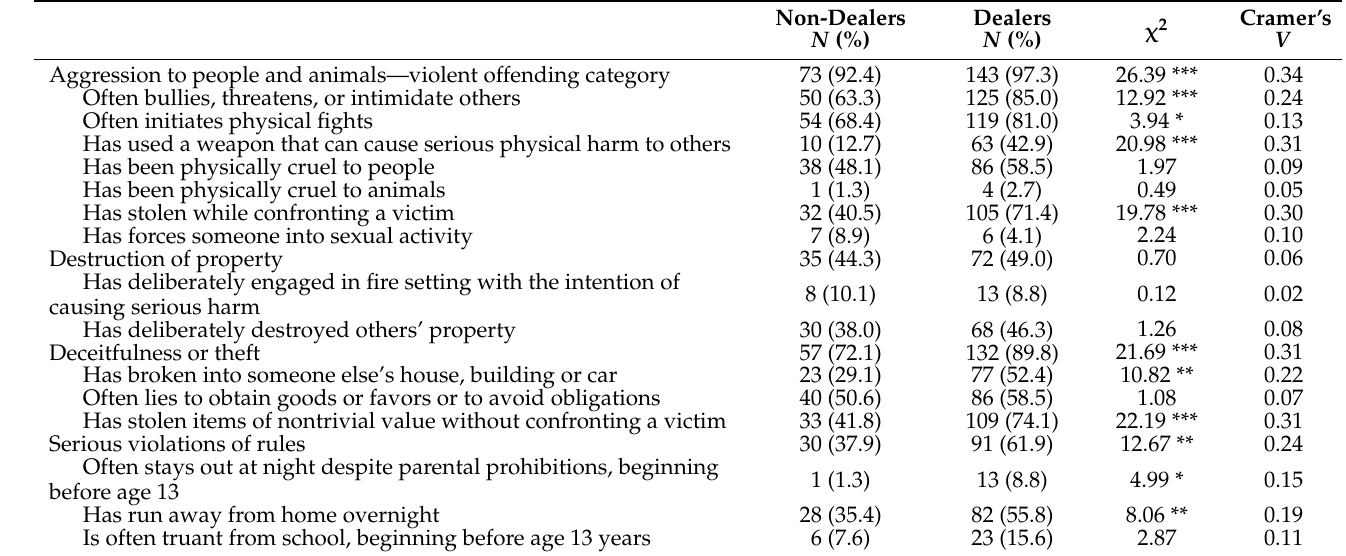
Table 1. Violent and Nonviolent Offenses Among Non-Dealers ( N = 78) and Dealers ( N = 147).